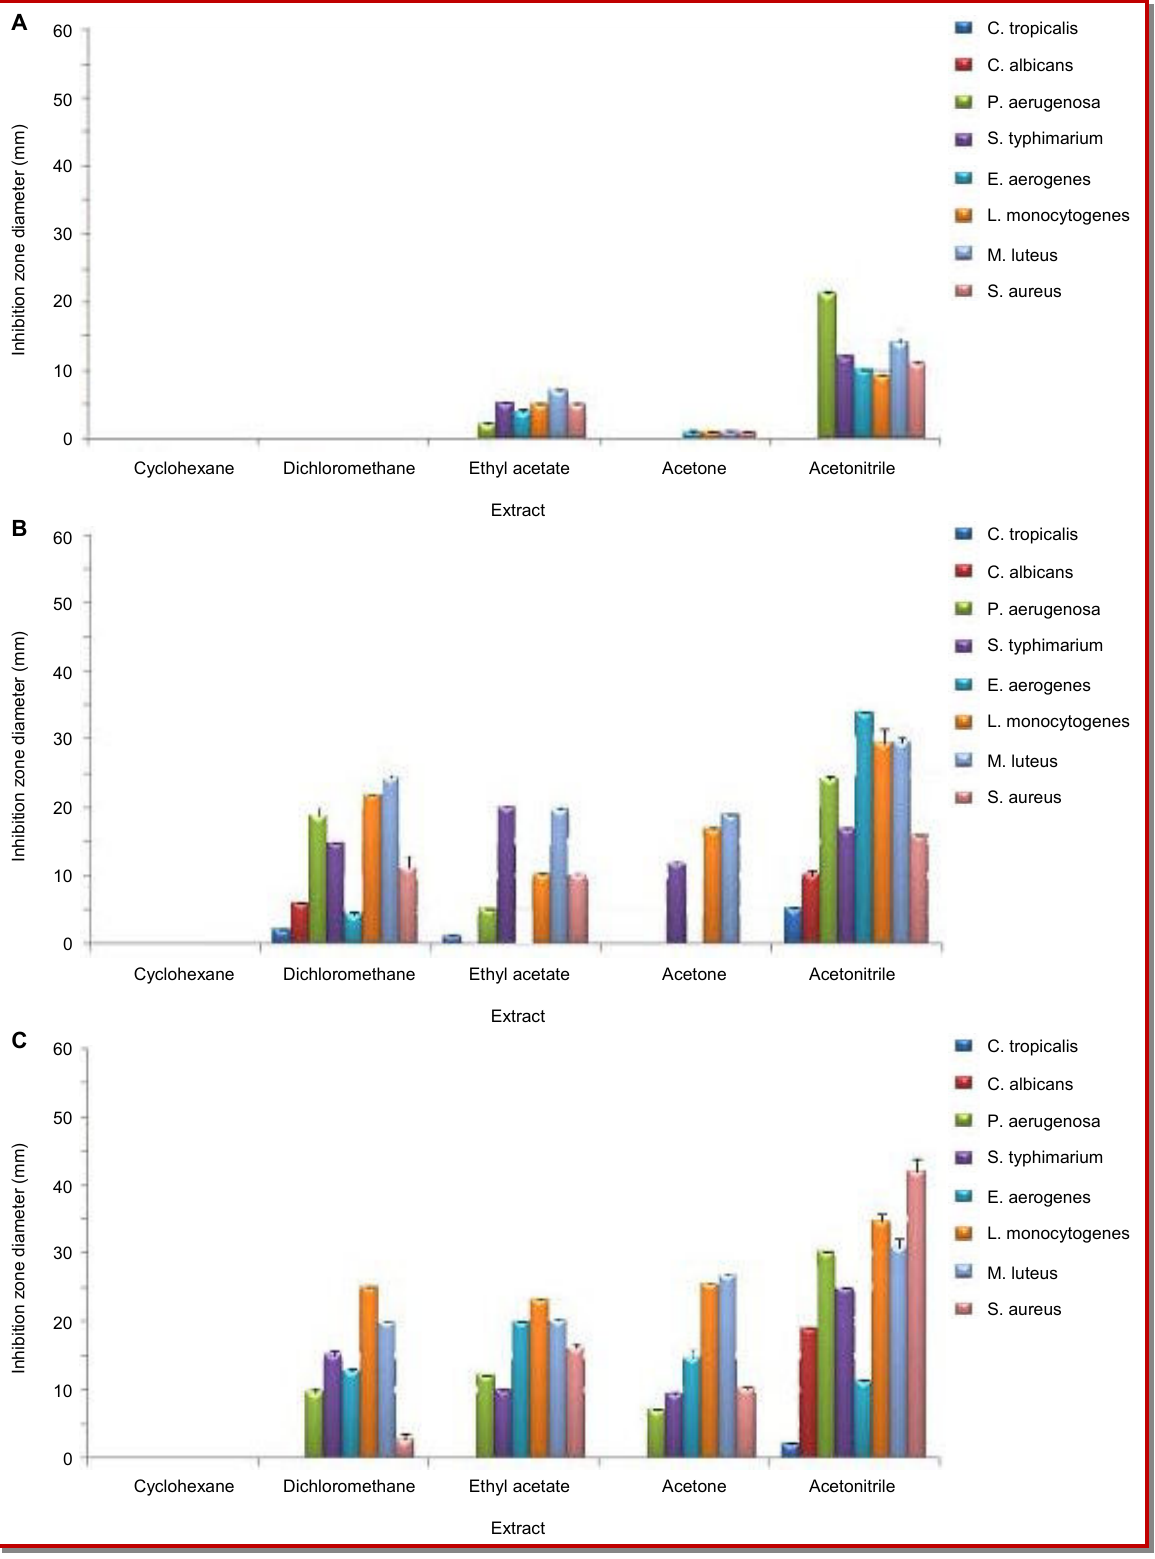
F igure 2: C. murale extracts antimicrobial activities by agar diffusion test (inhibition zone in mm). (A) stems extracts activities, (B) leaves extracts activities, (C) flowers extracts